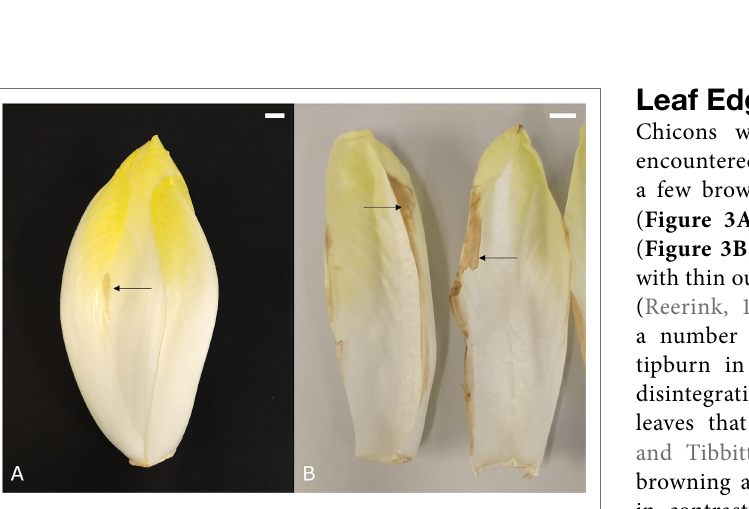
FIGURE 2 | Symptoms of pith discolorations in witloof chicory. (A) Spotted core browning, (B) layered core browning, (C) apple pith, (D) porous pith with pink discoloration, (E) hollow pith, and (F) glassy pith. Scale bars represent 1 cm.